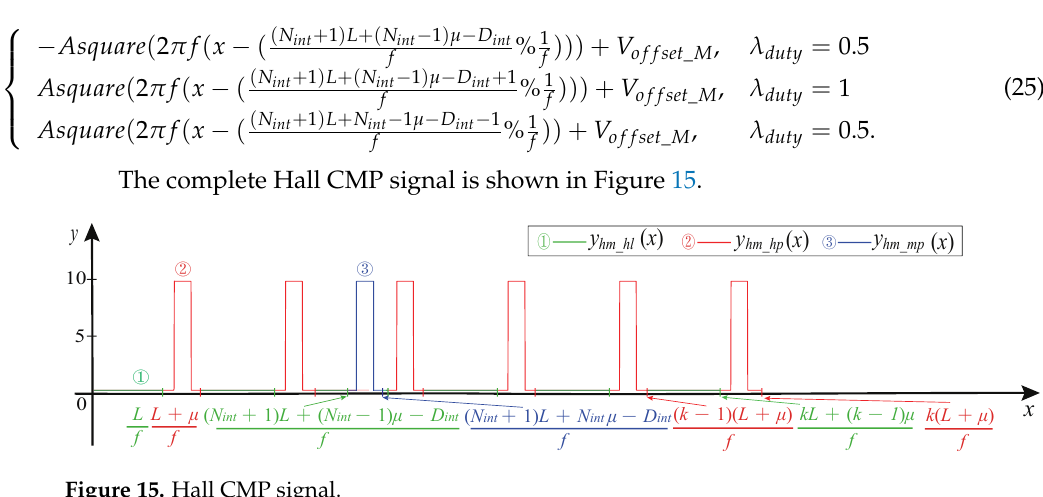
Stage 3: Marked pulse modeling. The rectangular marked pulse waveform is gener- ated according to Equation (25):